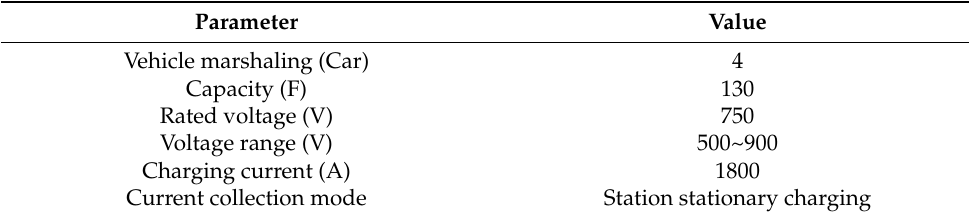
Table 1. Main technical parameters of on-board supercapacitors.